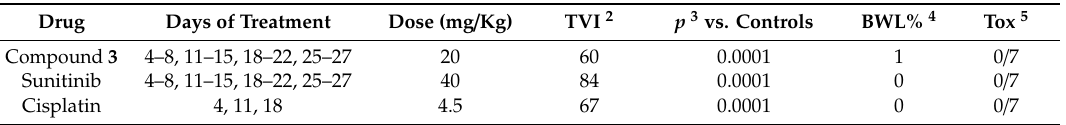
Table 1. E ff ects of i.p. compound 3 , oral sunitinib and intravenous cisplatin in nude mice s.c. bearing the IGROV-1Pt1 human ovarian carcinoma.